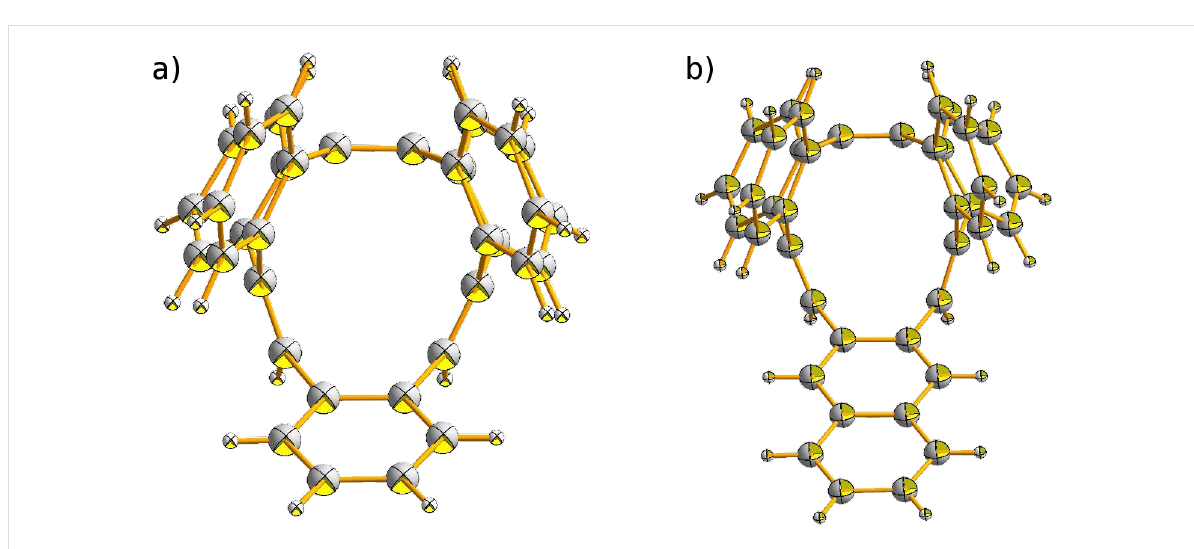
Figure 1: ORTEP drawing of the crystal structures: a) 2 and b) 3 . For additional perspective representations see Supporting Information File 1.